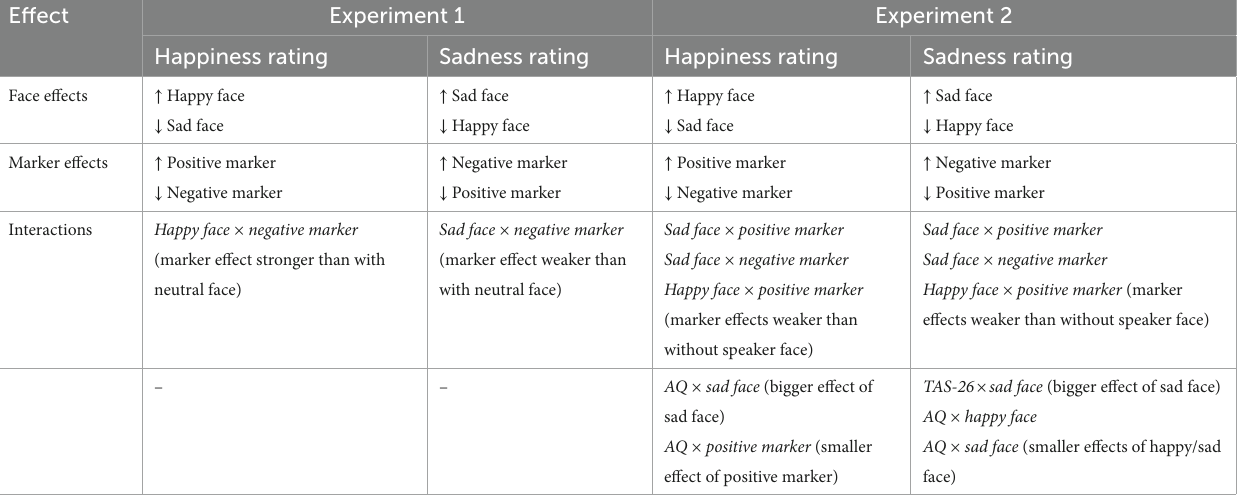
TABLE 1 Comparison of results on the emotion perception questions in Experiments 1 and